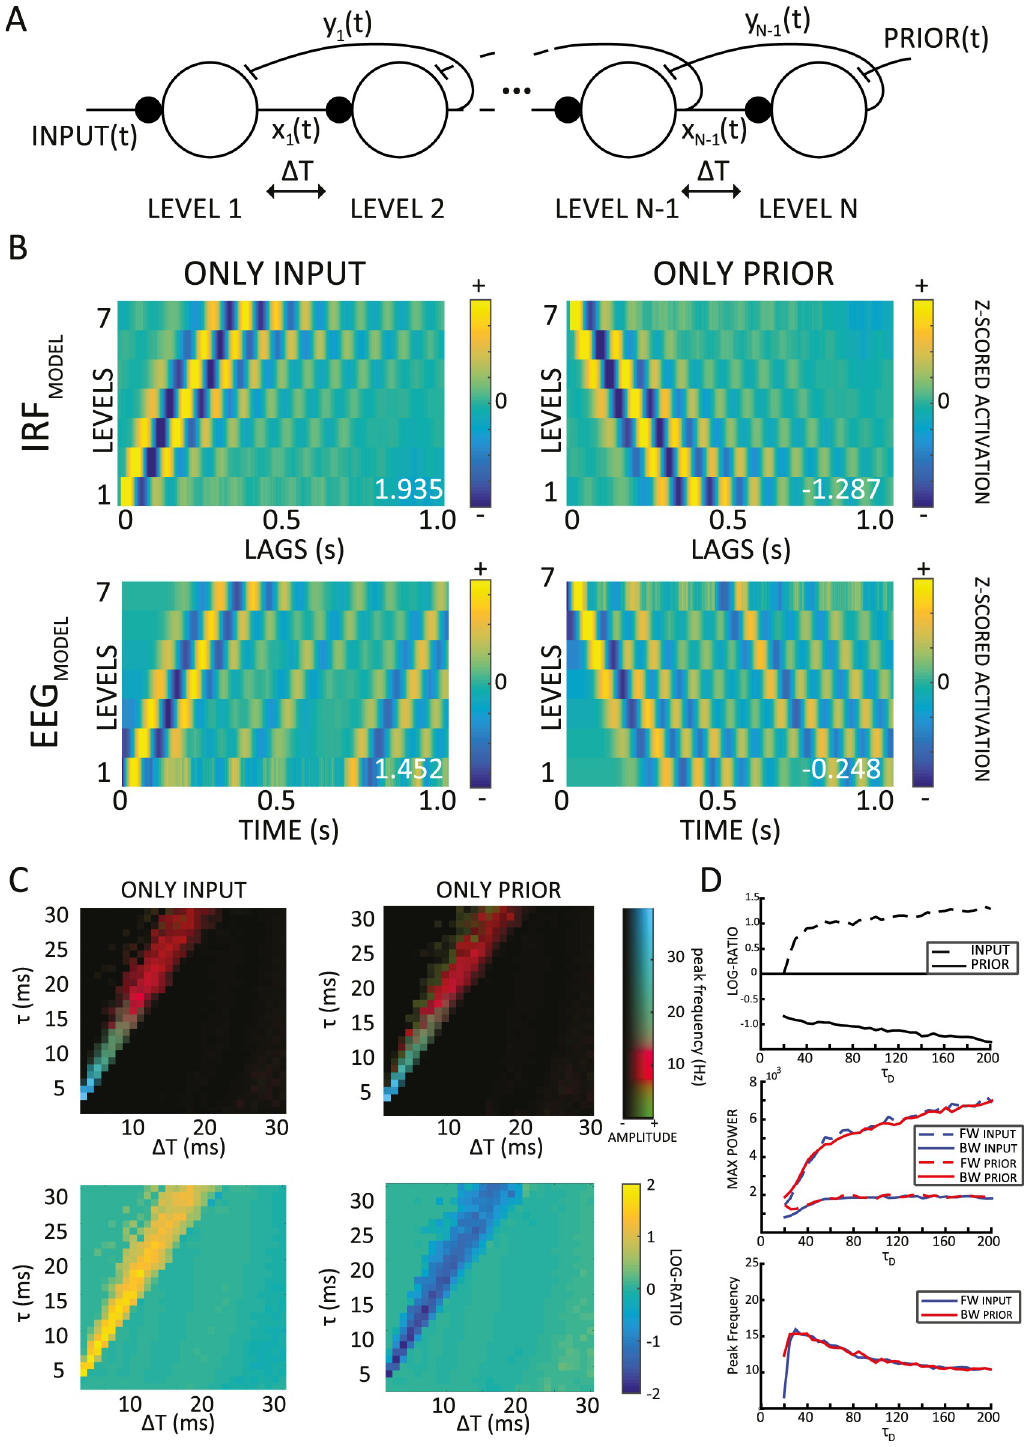
Fig 3. Alpha-band traveling waves in a hierarchical predictive coding model. (A) Multilevel version of the model: the same parameters ( Δ T = 12 ms and τ = 20 ms) are used throughout. The model is fed either a time-varying input (left) or a time- varying prior signal (right), reflecting top-down expectations computed in other parts of the brain. (B) Two-dimensional maps with only input (left column) or prior signals (right column): traveling waves are visible both in the IRF (computed by cross- correlating prediction signals with input or prior signals, top row) and in the raw prediction signals (considered as a proxy for